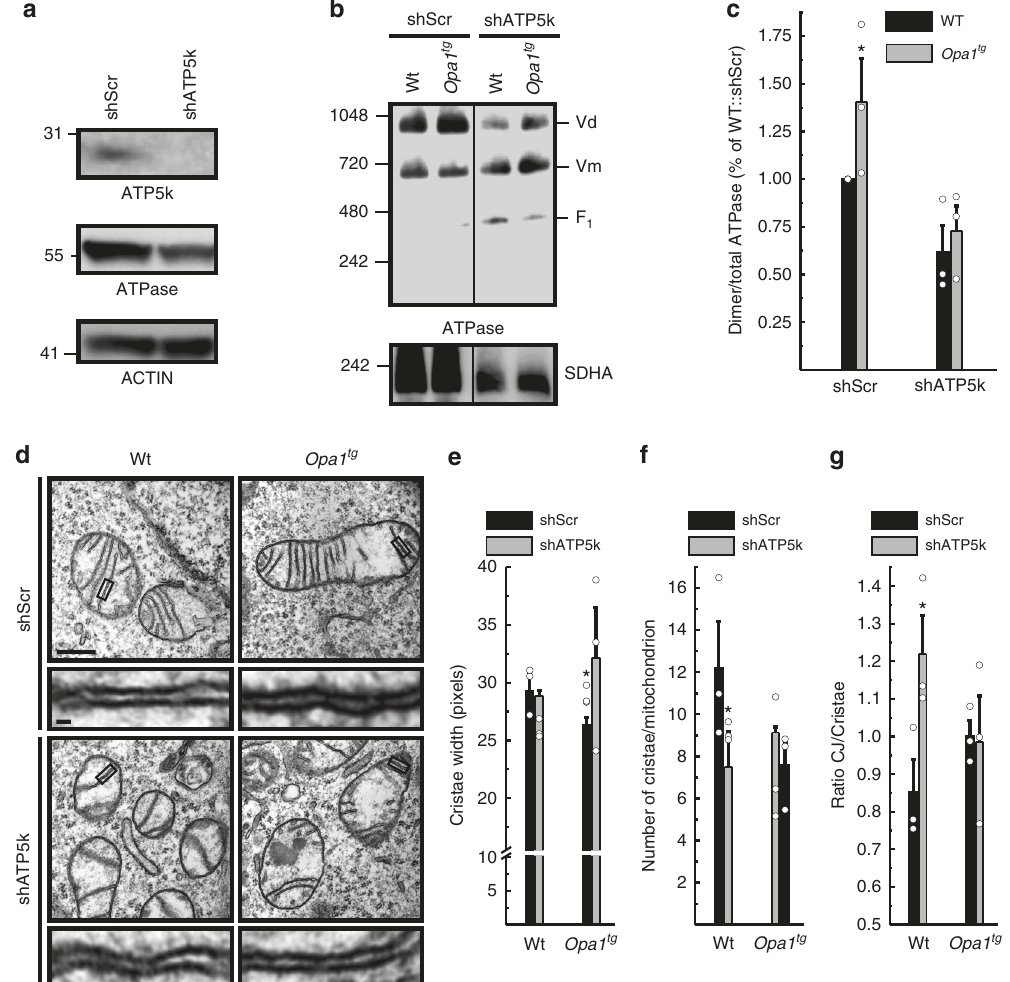
Fig. 6 OPA1 requires ATP5k to stabilize ATP synthase oligomers. a Equal amounts (30 µ g) of lysates from MAFs of the indicated genotype transfected for 48 h with the indicated shRNA were separated by SDS-PAGE and immunoblotted with the indicated antibodies (ATPase is ATP5A). b Equal amounts (40 µ g) of digitonin-solubilized mitochondrial extracts from MAFs of the indicated genotype transfected with the indicated shRNAs were separated by BNGE and immunoblotted with the indicated antibodies. c Quantitative densitometric analysis of ATPase dimer vs. total ATPase. Data are mean ± SEM of three independent experiments performed as in b . d Representative EM micrographs of cells of the indicated genotype transfected with the indicated shRNA and GFP and after 48 h sorted for GFP + and processed for EM. Boxed areas are magni fi ed 12× in the bottom images. Scale bars: 500 nm; 20 nm in bottom magni fi cations. e – g Morphometric analysis of cristae maximal width ( e ), number of cristae per mitochondrion ( f ) and cristae junctions per cristae ( g ) in experiments as in d . At least 30 mitochondria per experimental condition were analyzed. Mean values ± SEM of three independent experiments are shown. * p < 0.05 in a two-way ANOVA versus control ( e ) or paired two-sample Student ’ s t test versus scramble shRNA (shScr) ( f , g